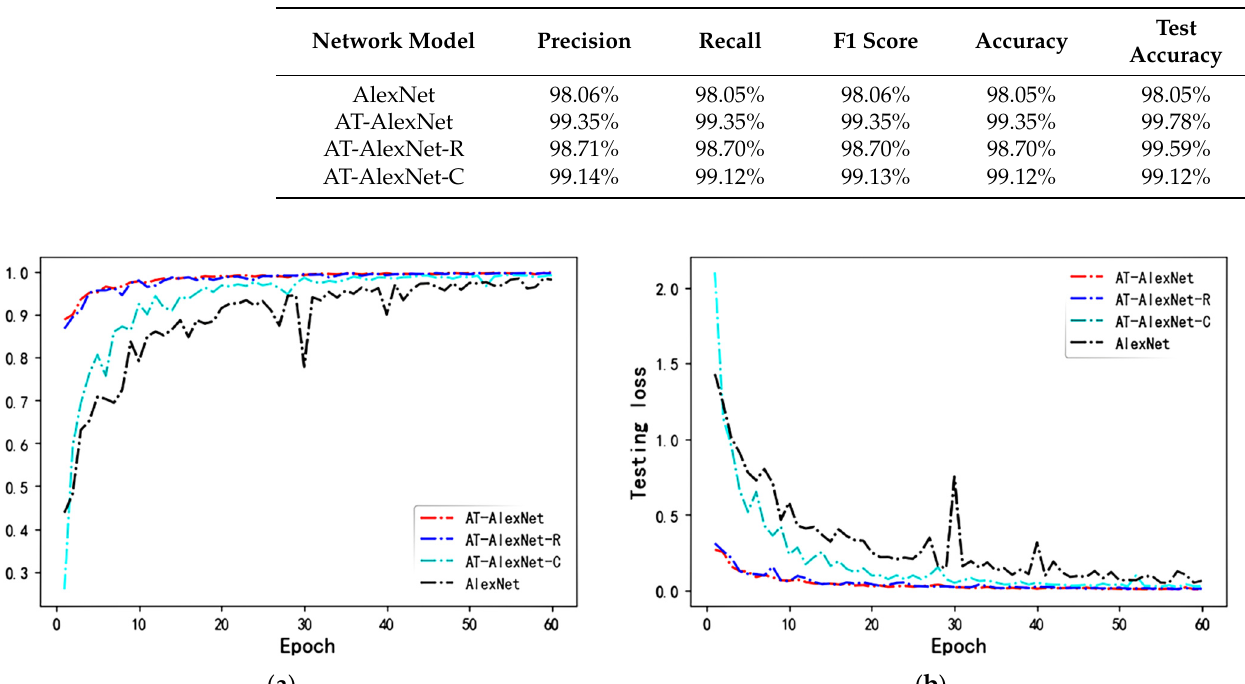
Figure 10. Test accuracy and loss value curves of different disease detection networks. ( a ) Testing accuracy; ( b ) Testing loss. Table 5. AT-AlexNet network ablation test.